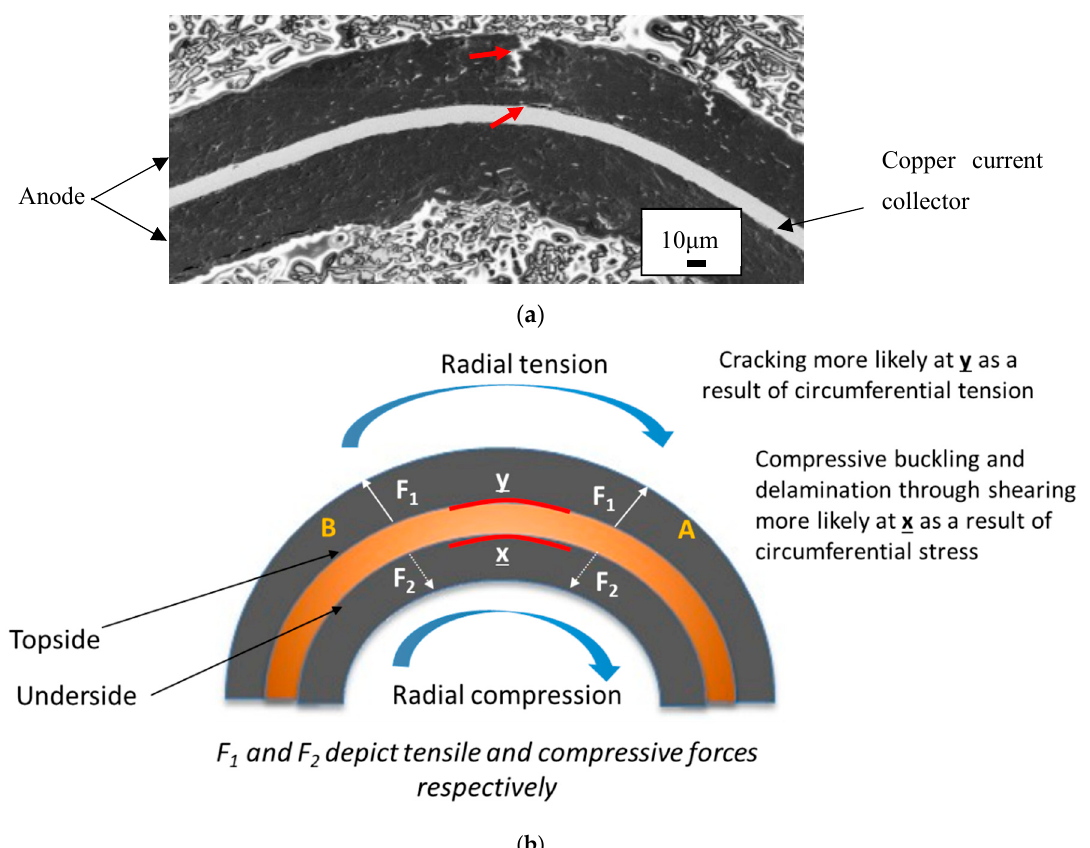
Figure 7. Micrograph ( a ) and schematic ( b ) of kinking observed.